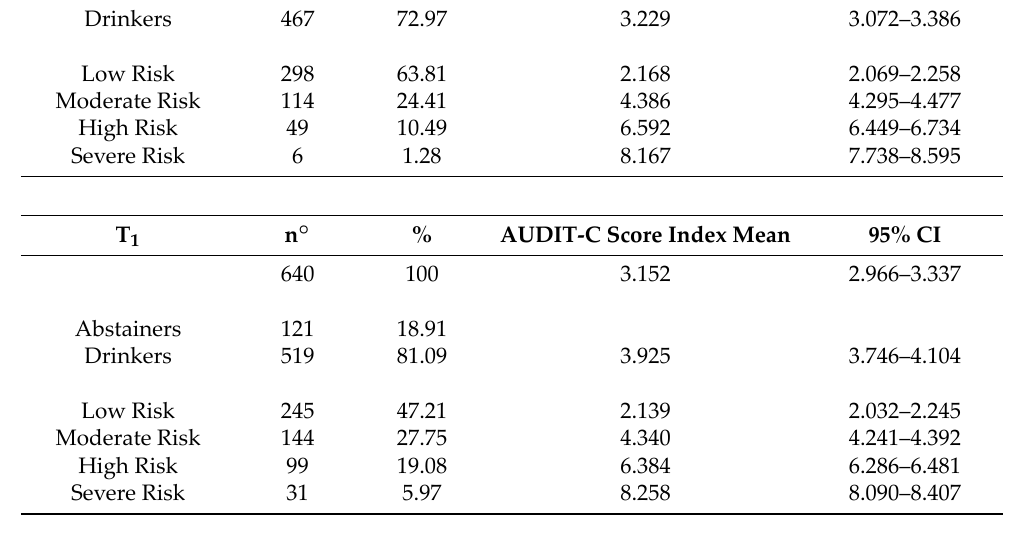
Table 1. Data on the use of alcoholic beverages and the risk of alcohol‑related problems. T 0 , T 1 = times during which the tests were administered and completed; n age; AUDIT‑C = Alcohol Use Disorders Identification Test‑Concise; CI = Confidence interval.